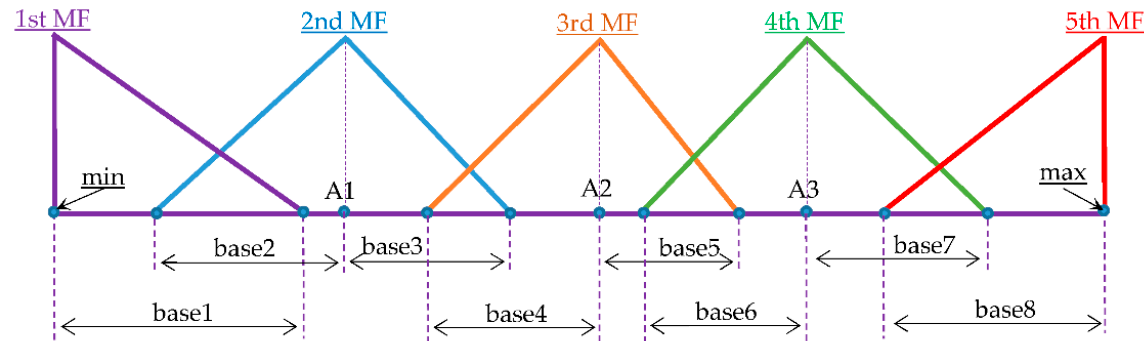
Figure 9. The triangular membership functions with their parameters.